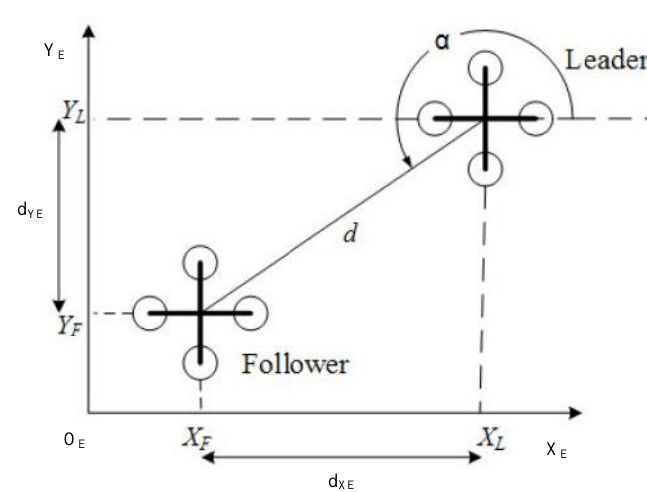
Figure 3. Schematic diagram of quadrotor formation distance.